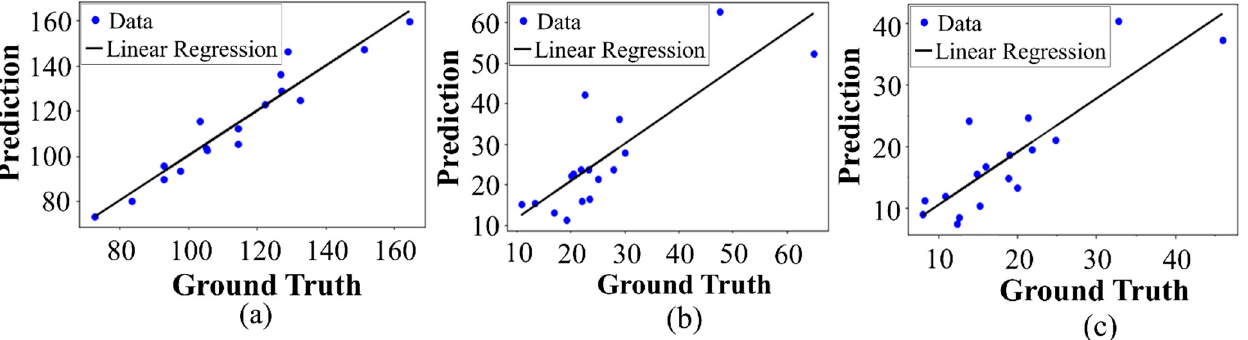
Figure 12. Correlation between the predicted vs. ground-truth values: ( a ) The correlation between prediction and ground-truth for LCD was around R² = 0.9649. ( b ) The correlation between prediction and ground-truth for LCCD was around R² = 0.6112. ( c ) The correlation between prediction and ground-truth for LCCI was around R² = 0.7015.